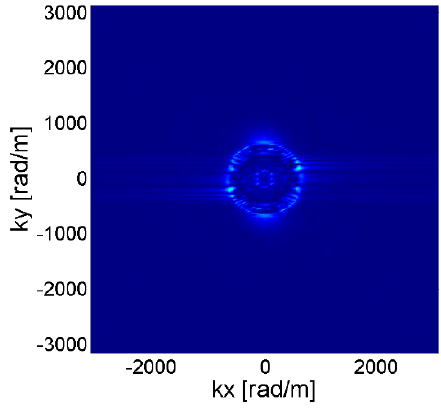
Figure 6. Filtered wavefield image captured at t 1 in the wavenumber–wavenumber domain.